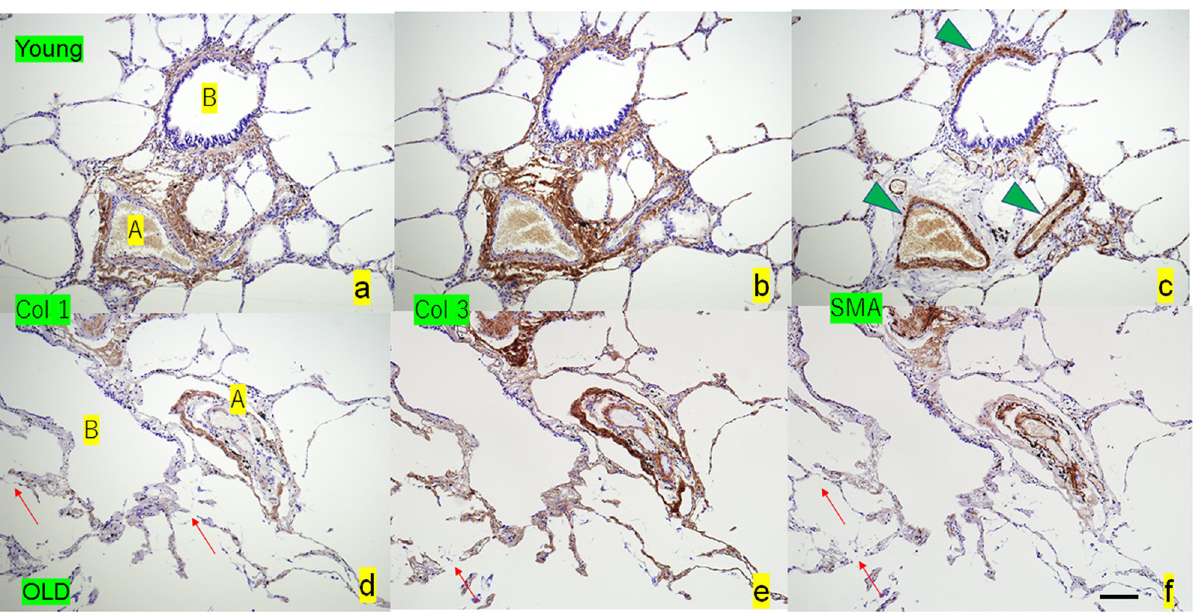
Fig 6. Comparison of immunostaining of type 1 and type 3 collagen and SMA between young and old lungs. The young lungs ( a , b , c ) exhibit small arterioles (A), bronchioles (B), and surrounding alveoli, with conspicuous collagen fibers and thick SMA fibers (arrowheads). Conversely, the old lungs ( d , e , f ) exhibit dilated bronchioles, thin arterioles with double contours, and disconnected alveoli (arrows), showing weak discontinuous collagen and SMA staining. A, arteriole; B, bronchiole; Col 1, type 1 collagen; Col 3, type 3 collagen; SMA, smooth muscle actin. Scale bar = 200 μ m.